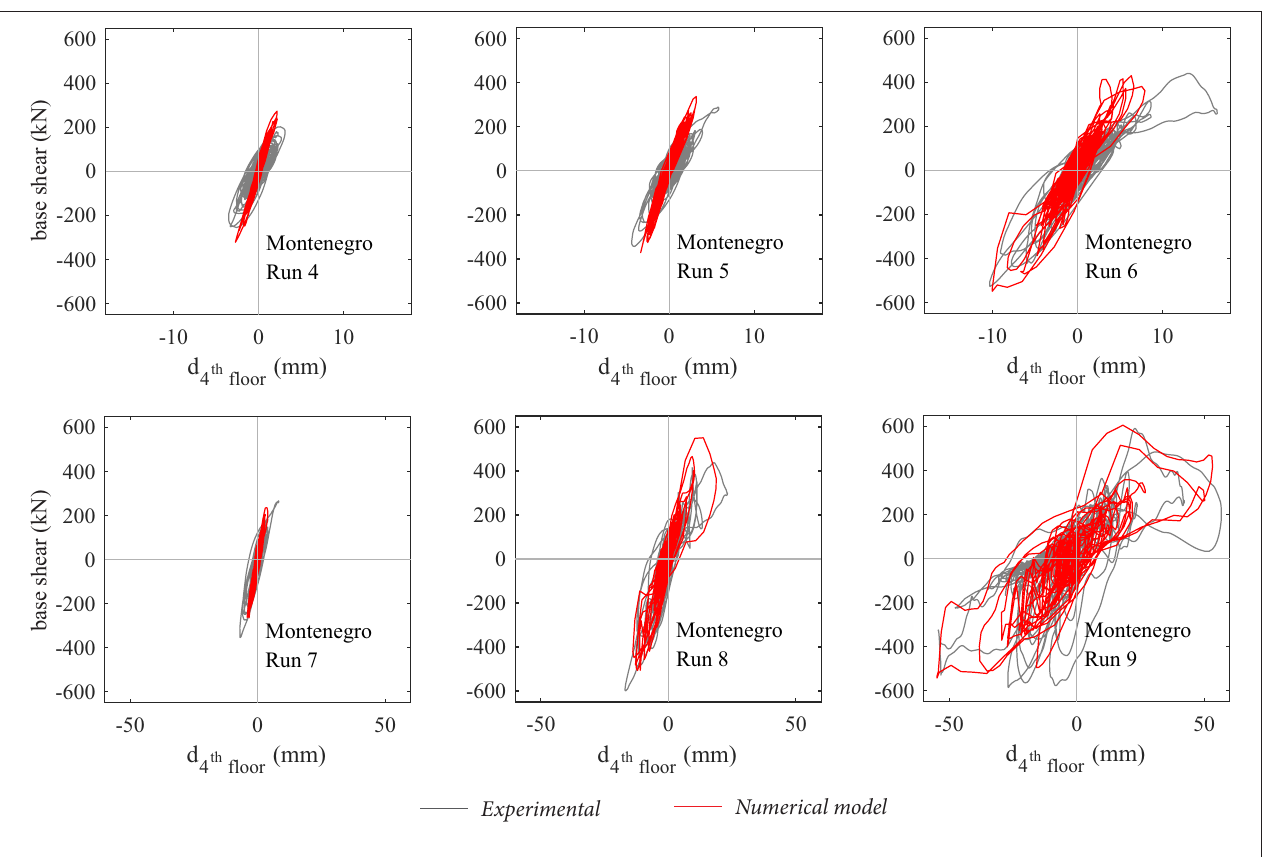
FIGURE 14 | Mixed RC/URM building: force displacement global response of the building (damping ratio ζ = 1 % ).